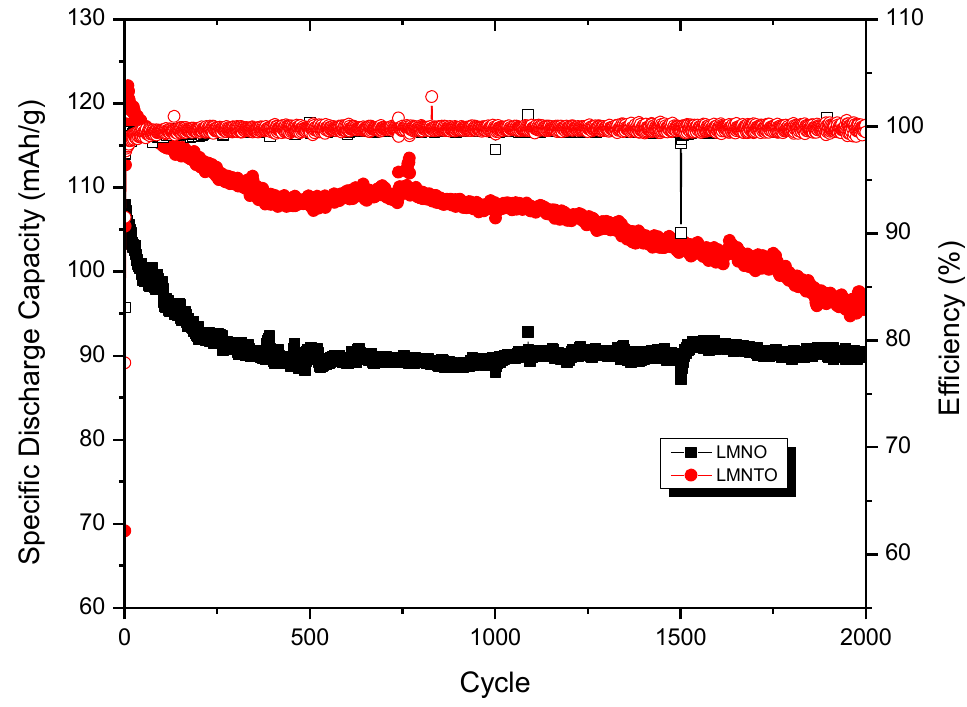
Figure 7. Cycling performance of LMNTO vs. LMNO materials in half cells showing specific discharge capacity for 2000 cycles.